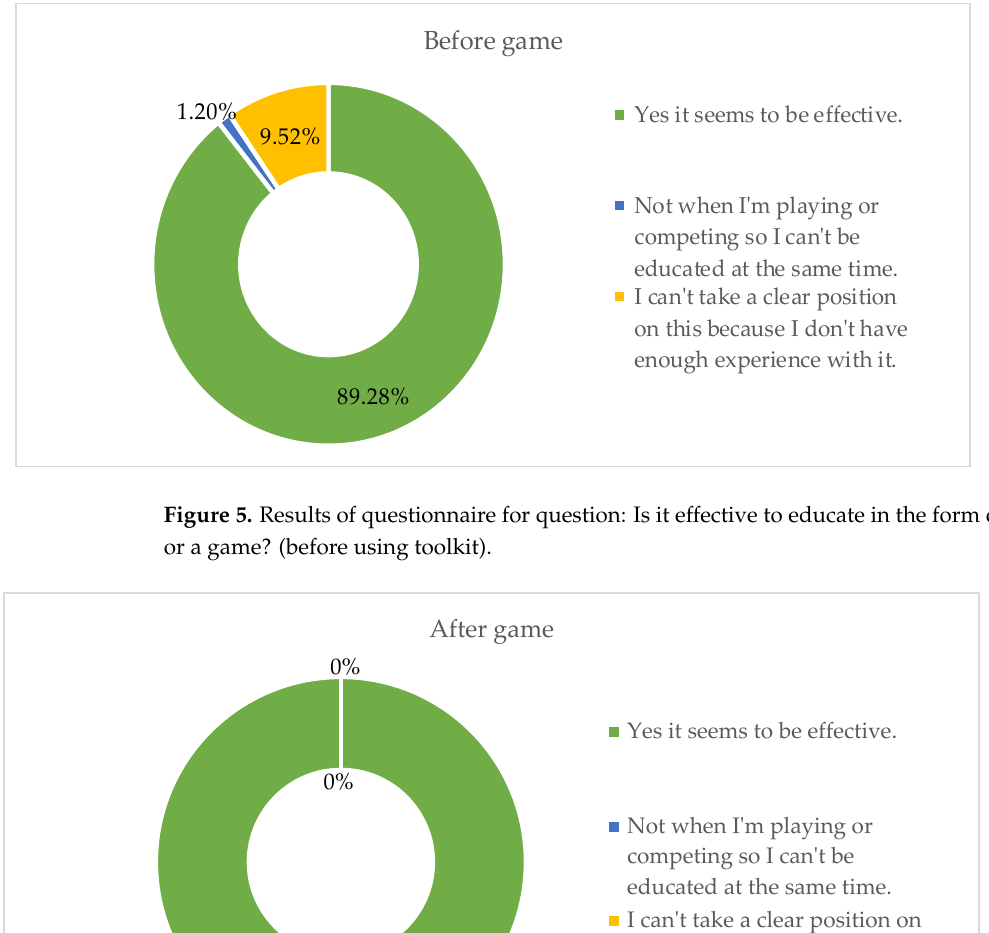
Figure 4. Results of questionnaire for knowledge questions.